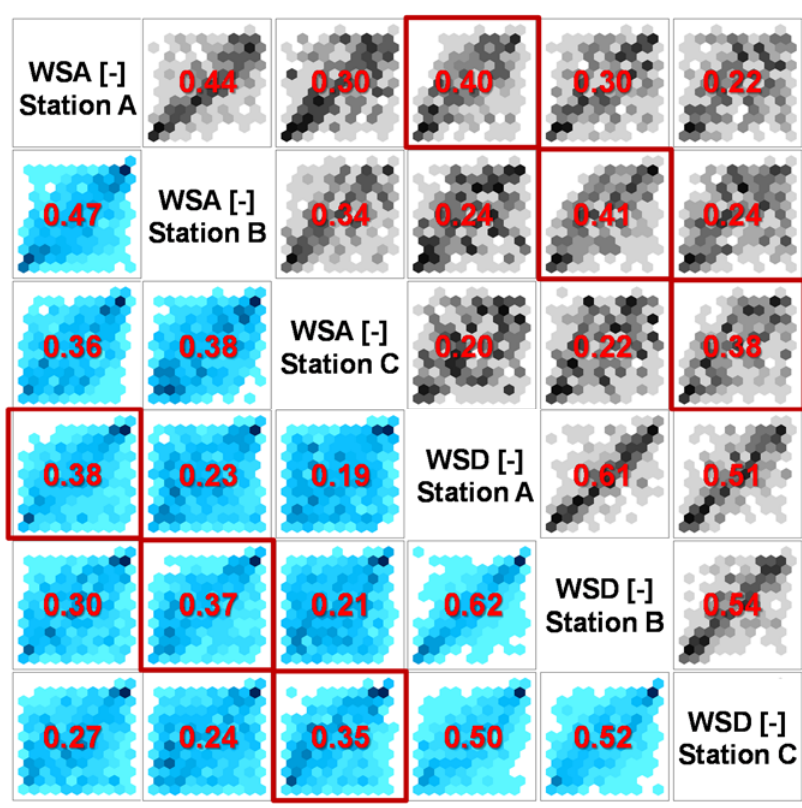
Figure 6. Pairs of pseudo-values of summer events occurring in three stations simultaneously for the BAWU_B case (Kendall’s Tau in red). Upper triangular matrix: Observed. Lower triangular matrix: Synthetic.